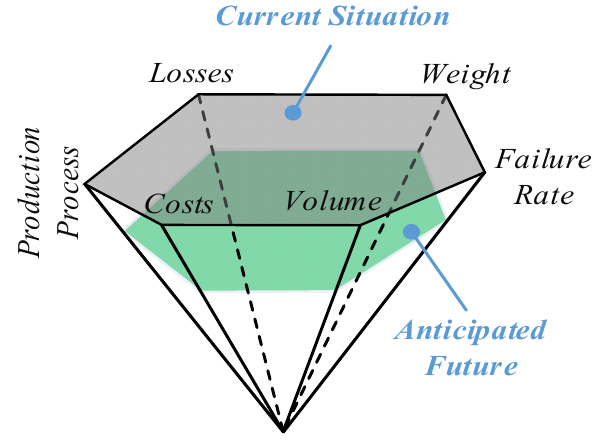
Figure 1. Anticipated power electronics objectives.